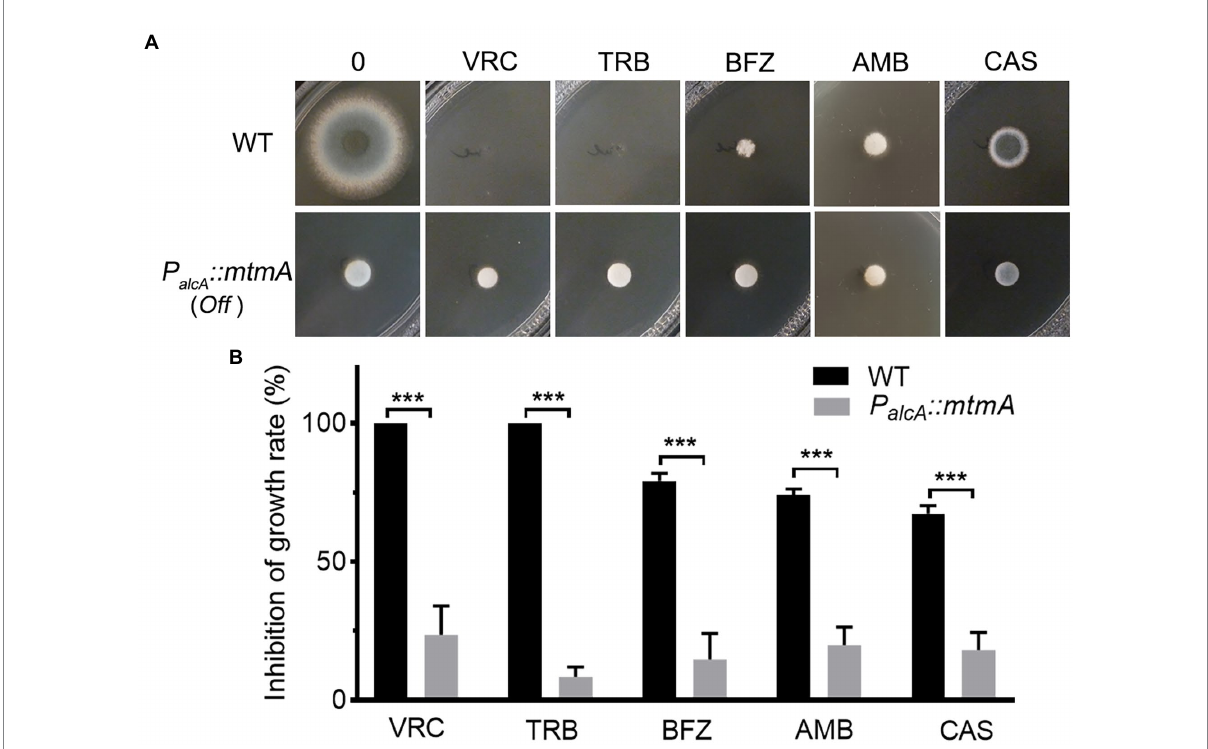
FIGURE 4 Repressed expression of MtmA causes multidrug resistance. (A) Colony morphology of the indicated strains inoculated on YAG medium without drug at 37 ° C for 1.5 days or with drug at 37 ° C for 2 days. The following antifungal drugs were used: 0.2 μ g/ml voriconazole (VRC), 0.6 μ g/ml terbinafine (TRB), 1.2 μ g/ml bifonazole (BFZ), 3 μ g/ml amphotericin B (AMB) and 0.5 μ g/ml caspofungin (CAS). (B) Mycelium growth inhibition ratios of the indicated strains with different concentrations of the indicated drugs. Error bars indicate the mean ± SD of the results from three independent experiments. Statistical significance was determined by Student’s t test. ***, p <